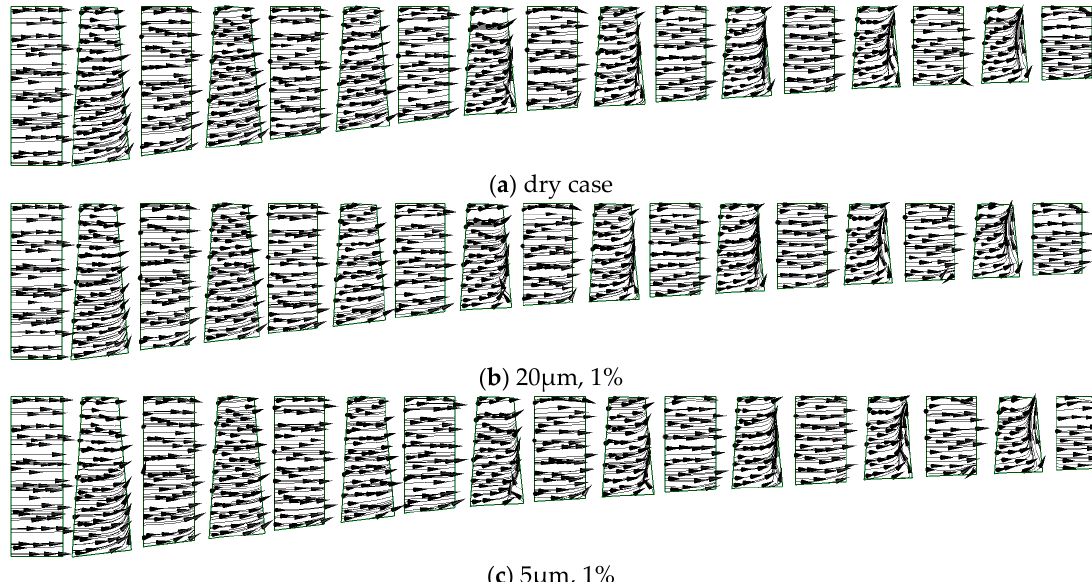
Figure 23. Limiting streamlines on suction surfaces of the compressor blades and injecting water of different droplet sizes.